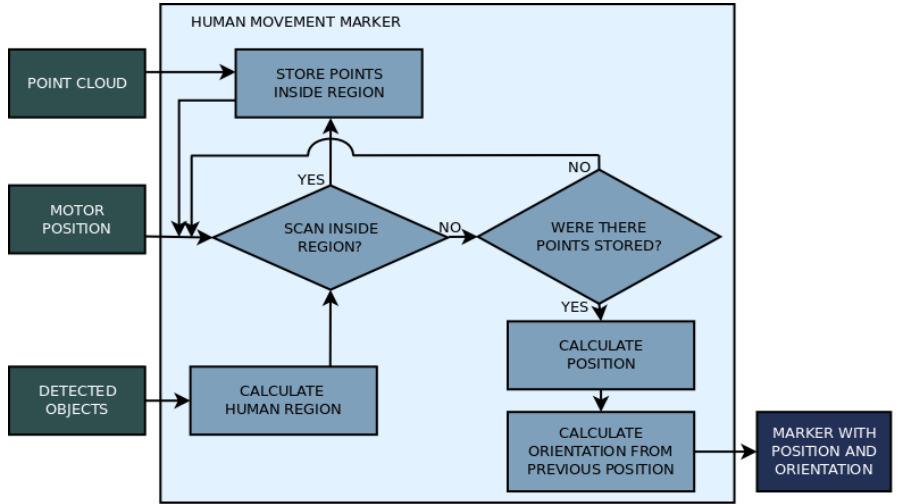
Figure 10. Flow chart of the human movement prediction